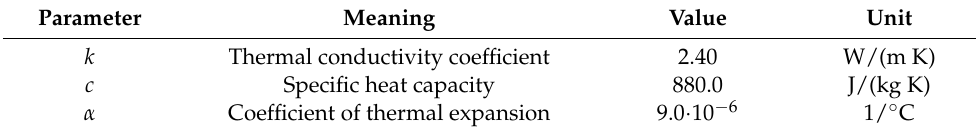
Table 6. Rock mass thermal parameters.